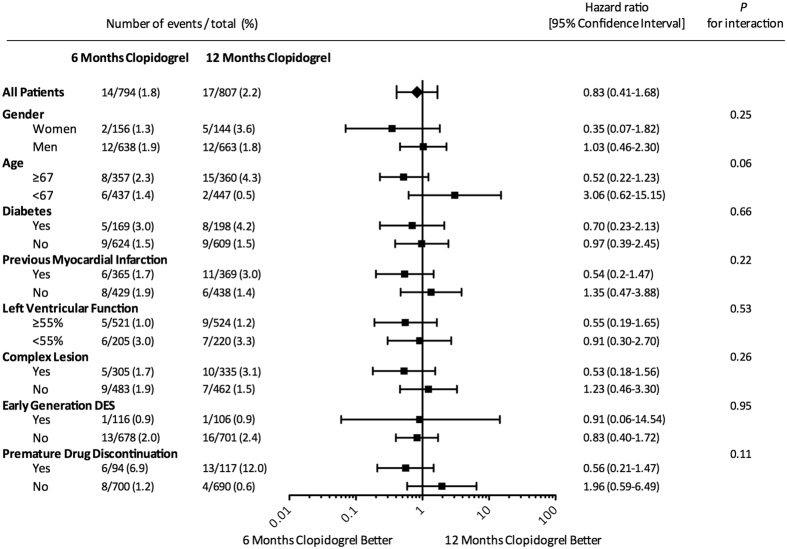
Incidence of The Primary Endpoint in Subgroup Analysis – DES = Drug Eluting Stent.